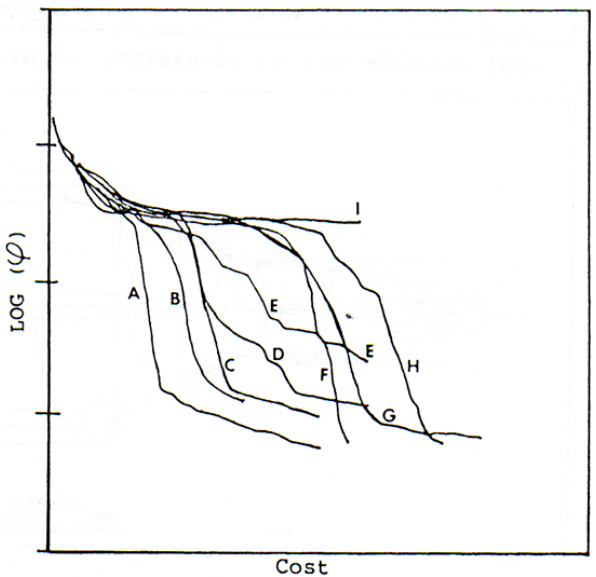
Figure 1. Comparison of convergence rates for several algorithms. Curve A is for PSD III, and curve I is classic damped-least-squares (DLS).